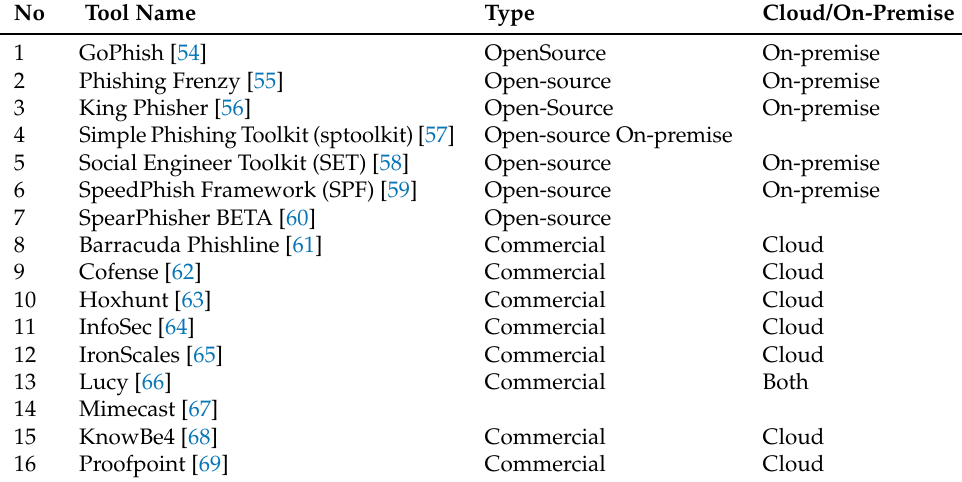
Table 3. Phishing simulation